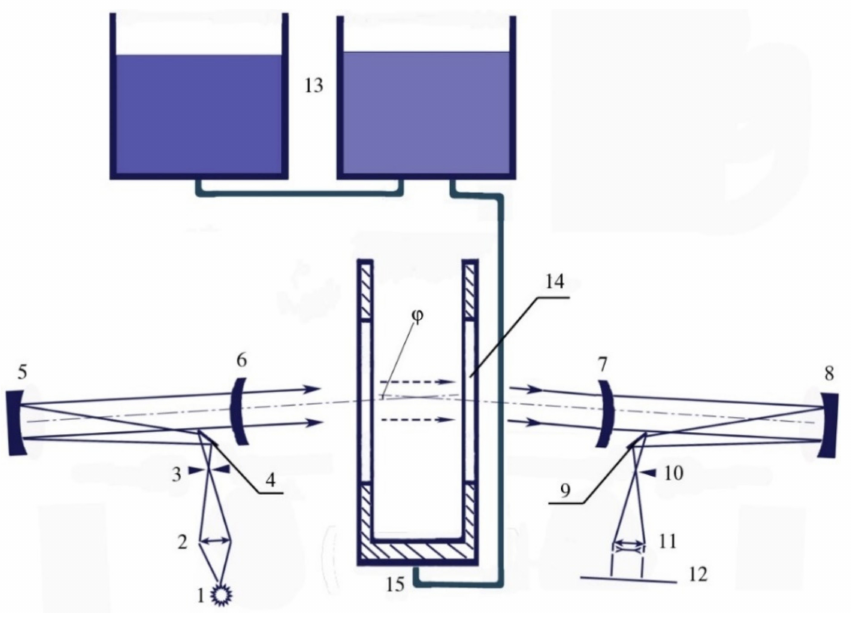
Figure 3. Optical scheme of the experimental